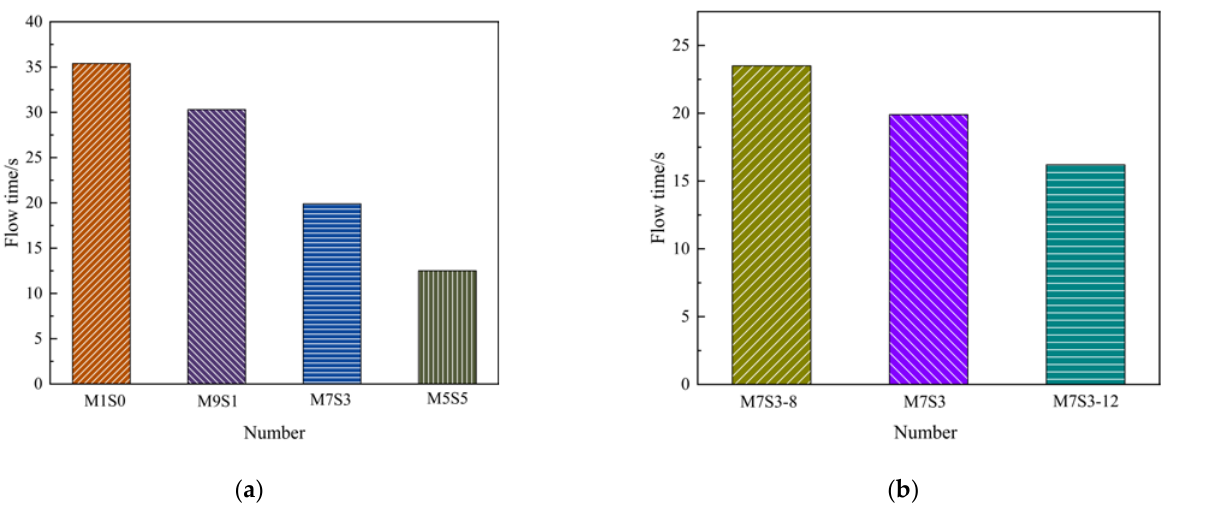
Figure 2. Fluidity of AAMS composite cementitious materials. ( a ) Different slag contents. ( b ) Different Na 2 O contents.